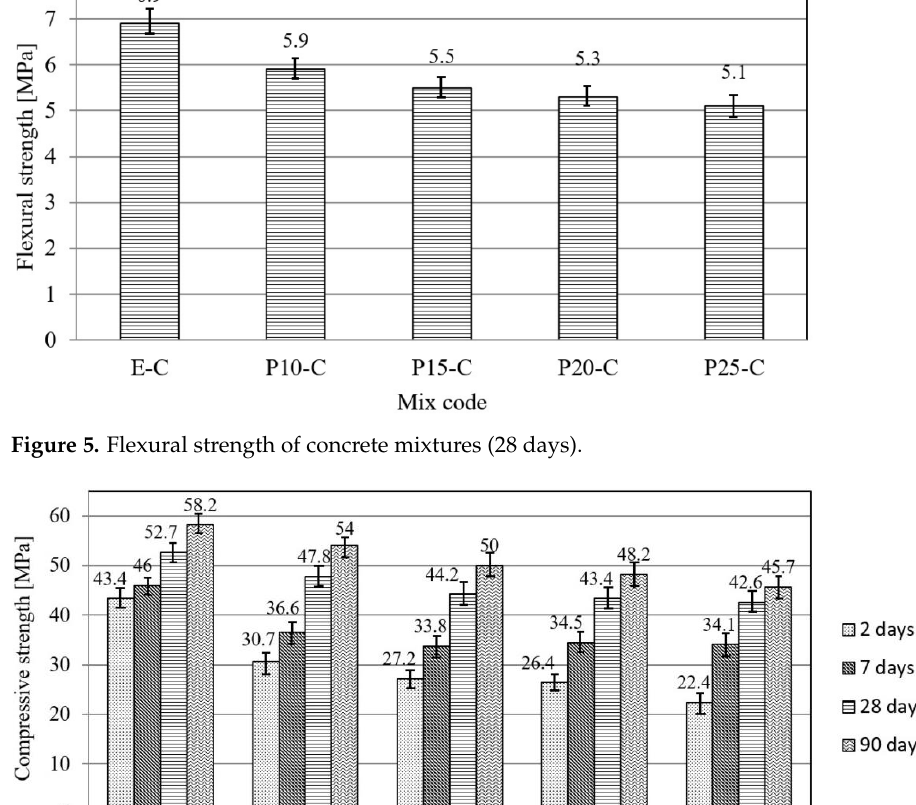
Figure 7. XRD analysis of the hardened mortar sample P20-M.